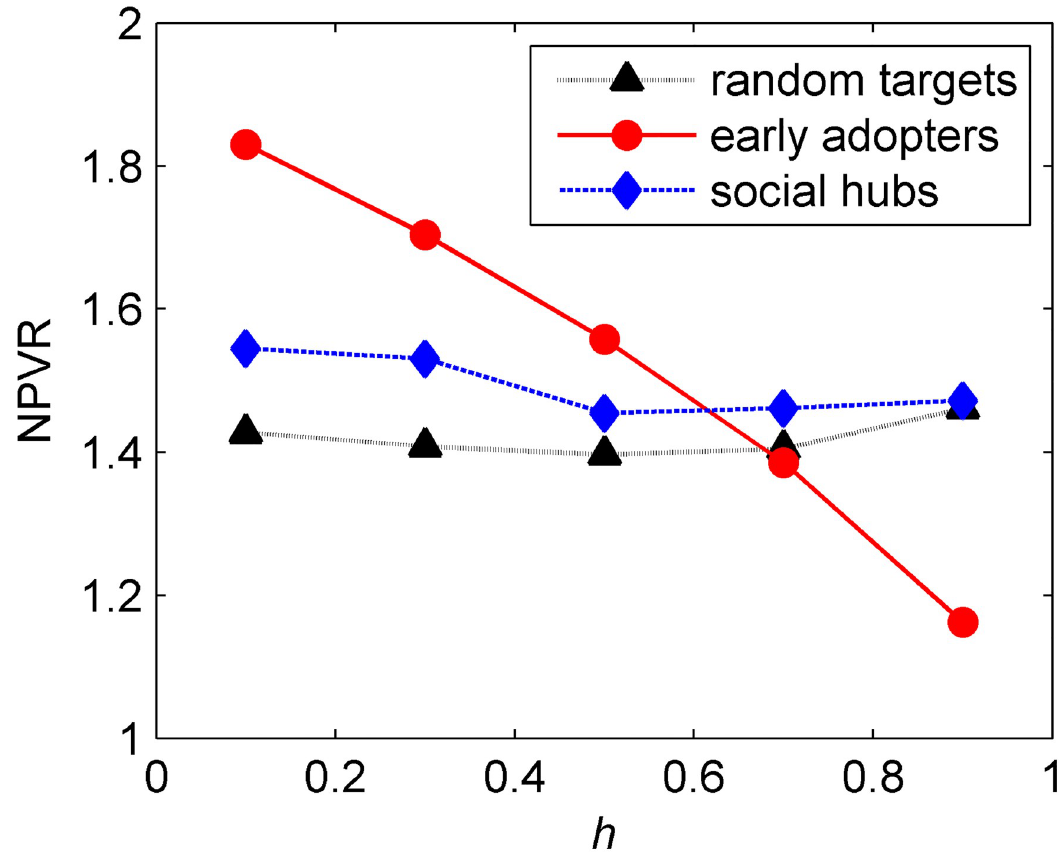
Fig 7. Impact of levels of homophily on the NPVR for three seeding targets. In Fig.7, the abscissa represents the level of homophily, while the ordinate represents the change in the ratio of net present